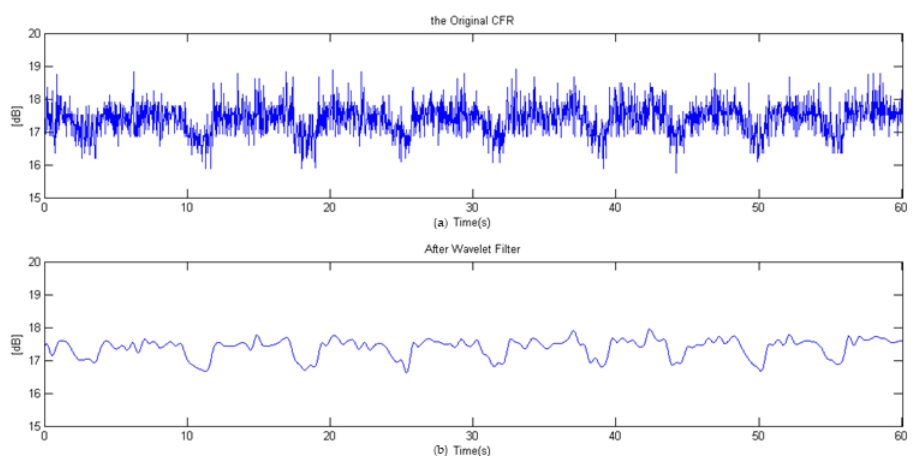
Figure 6. Amplitude information for Subcarrier # 7. ( a ). Raw coughing pattern obtained using C-Band. ( b ). Filtered coughing pattern.